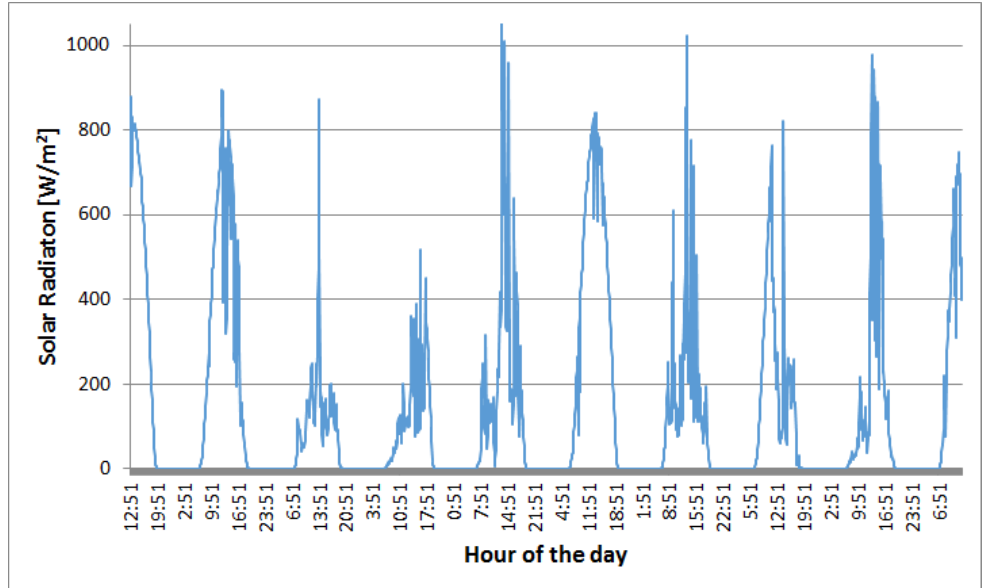
Figure 5. Solar irradiance during the second monitoring campaign.